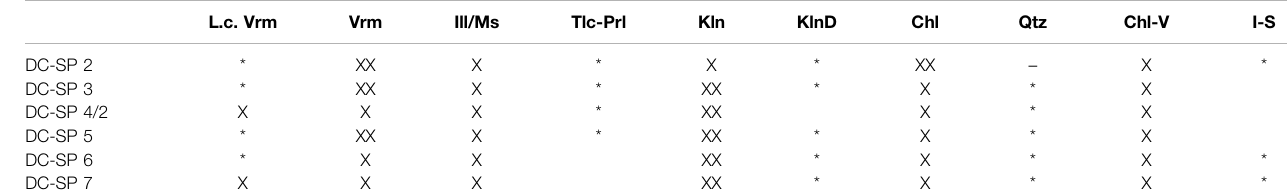
Data is obtained by modal analysis of Light mineral fraction (performed on fraction 0.09 – 0.16 mm), and by Quantitative XRPD analysis. Quantitative mineral compositionof bulk samples and semi-quantitative mineral composition of the < 2 µm fractionis are shown. Abbreviation codes: Qtz — quartz, Pl — plagioclase, Gbs — gibbsite, Hem — hematite, HA — hydroxylapatite, 14, 10, 9, 7 Å — type of clay minerals present in bulk sample marked with +, ? — mineral is probably present in the sample but cannot be con fi rmed with certainty because of low content and/or overlapping of diffraction maximums. L.c. Vrm — Low-charge vermiculite or high-charge smectite, Vrm — vermiculite, Ill/Ms — illite/muscovite, Tlc-Prl — talc-pyrophillite group, Kln (cid:2) Kaolinite which does not intercalate with DMSO, KlnD — kaolinite which forms intercalation compounds with DMSO, Chl — chlorite, Chl-V — chlorite-vermiculite mixed-layerd clay mineral, I-S — illite-smectite mixed-layerd clay mineral, XXX — dominant ( > 50%), XX — abundant (20 – 50%), X — subordinate (1 – 20%), * — traces ( <